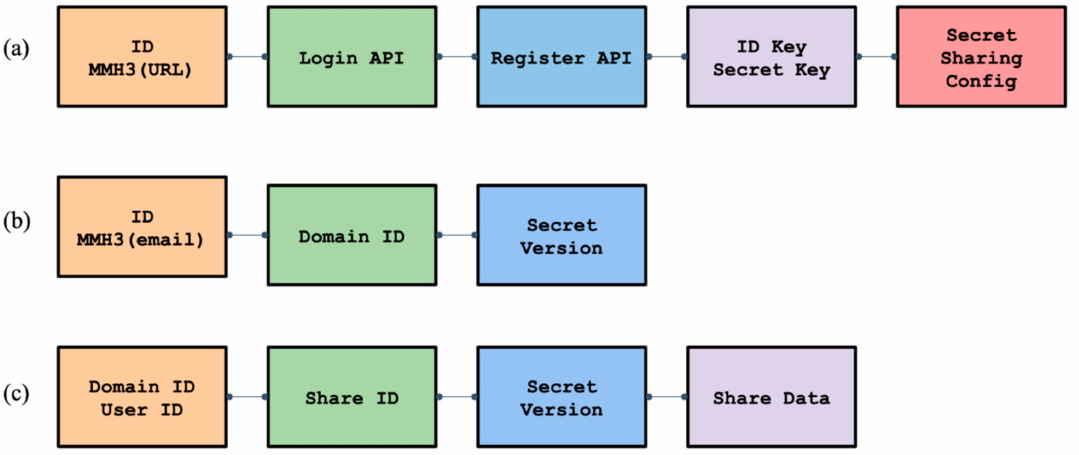
Figure 2. Bingo’s data model utilizes a set of three basic